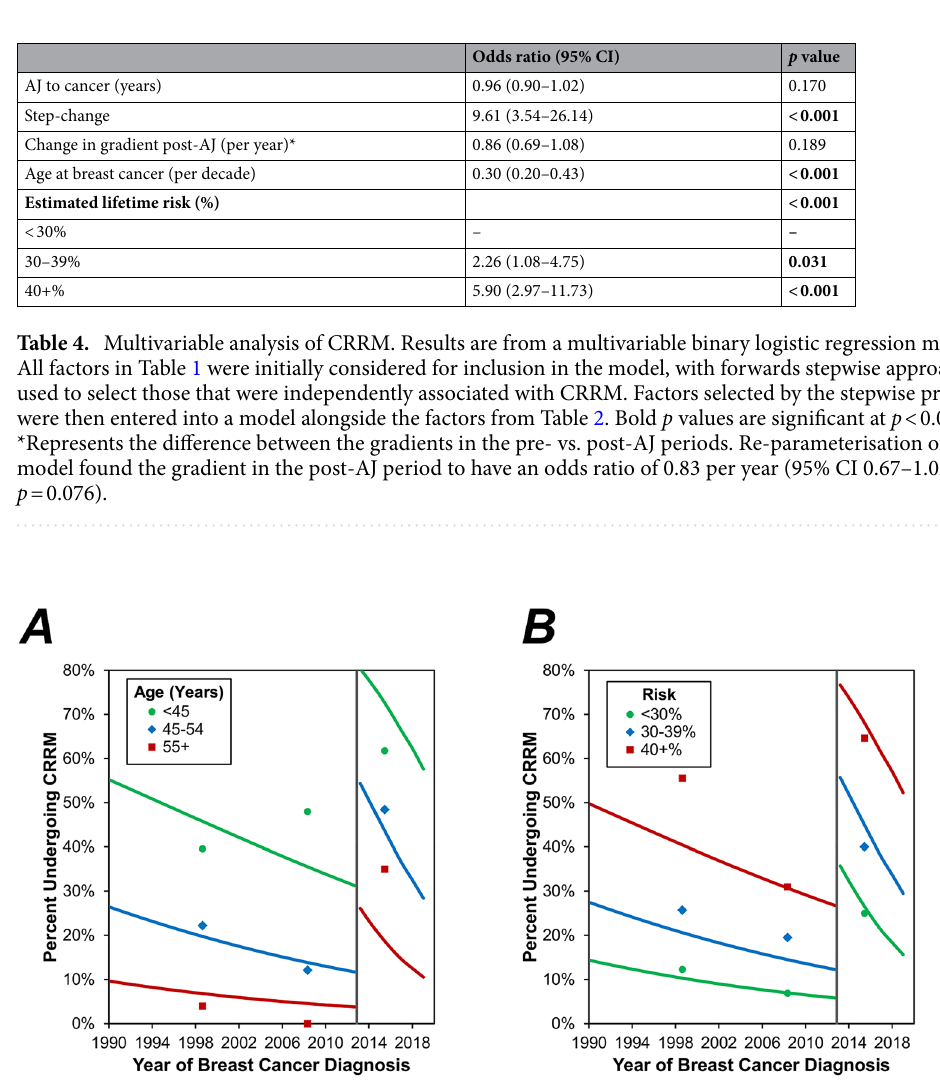
Figure 2. Multivariable analysis of CRRM by age and estimated lifetime risk. Points represent the observed rate of CRRM in three periods (1990–2004, 2005-AJ, AJ-2019), and are plotted at the midpoint of the interval. Trend lines represent the multivariable model reported in Table 4, which was evaluated within each of the age and estimated lifetime risk categories, respectively. These trend lines are for the “average” patient; hence ( A ) is evaluated based on the distribution of risk categories from Table 1, and ( B ) based on an age of 47.8 years. The grey line indicates the timing of the AJ